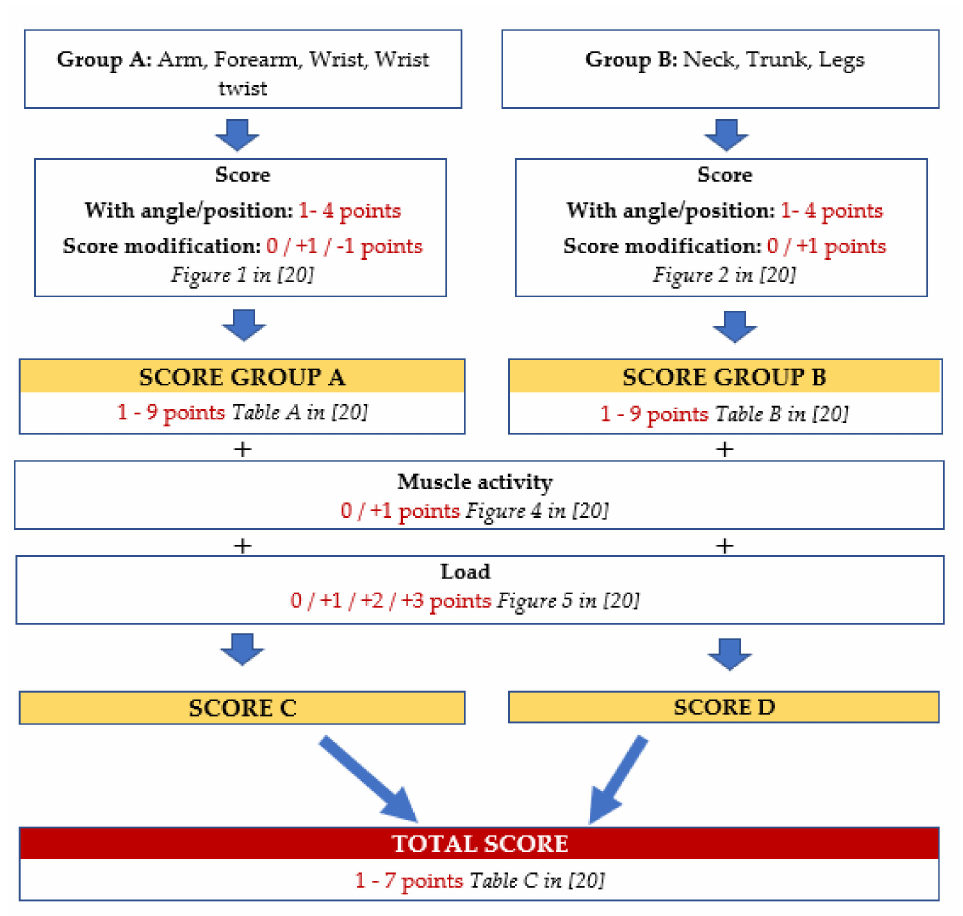
Figure 3. RULA Scores